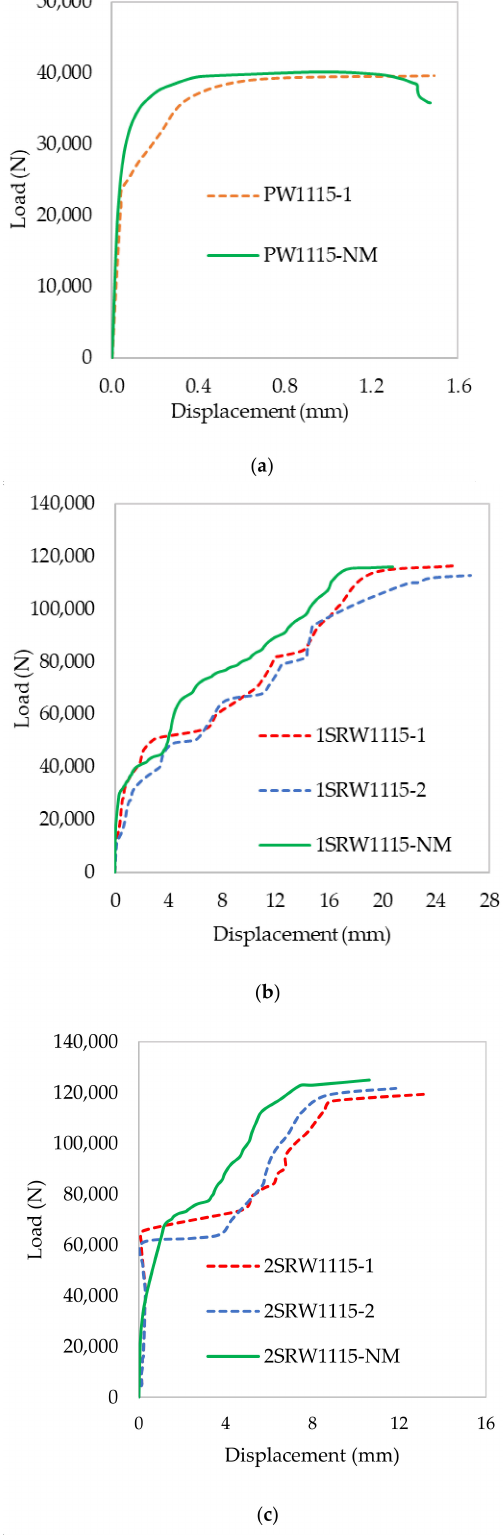
Figure 20. Load–displacement curve for the large-scale model: ( a ) plain wall, ( b ) one-side retrofitted wall, ( c ) two side retrofitted